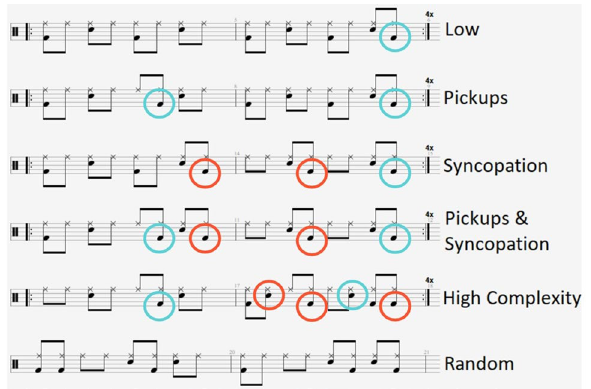
Figure 1. Musical notation for our drumbeat stimuli. Pickups are circled in blue while syncopations are circled in